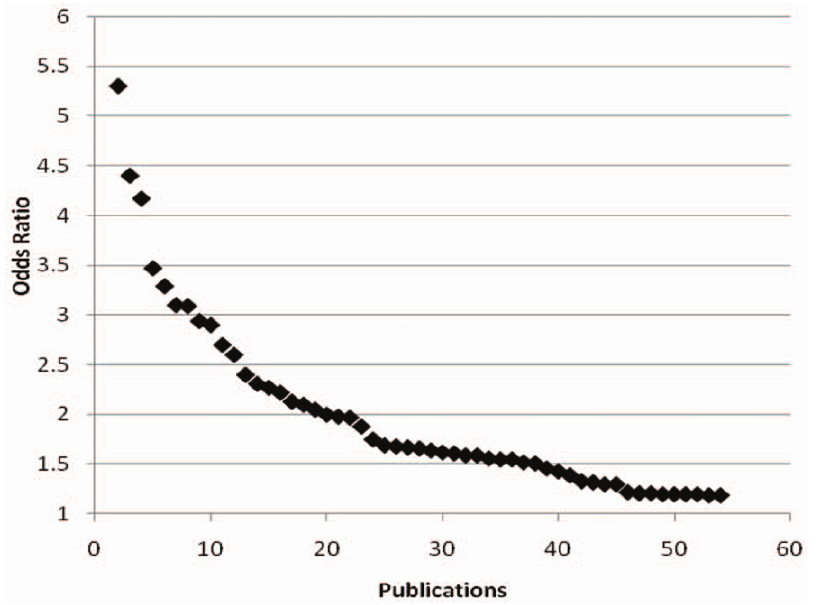
Figure 2. Distribution of effect sizes for infectious disease-related GWAS as reported in the NHGRI Catalog, 2001–2010. One outlying association with an OR of 27.1 ( IL28B and HCV treatment; Tanaka 2009) is not shown.